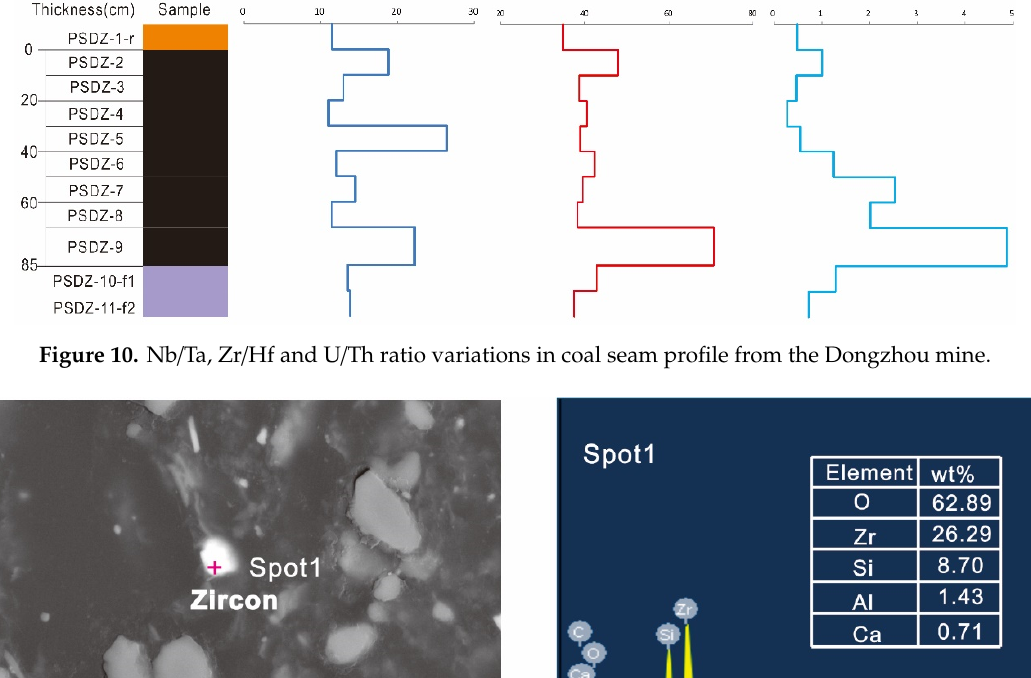
Figure 11. SEM back-scattering images of zircon in sample PSDZ-2 from the Donggou mine ( A ) and the energy dispersive spectrum data of spot 1 ( B ).